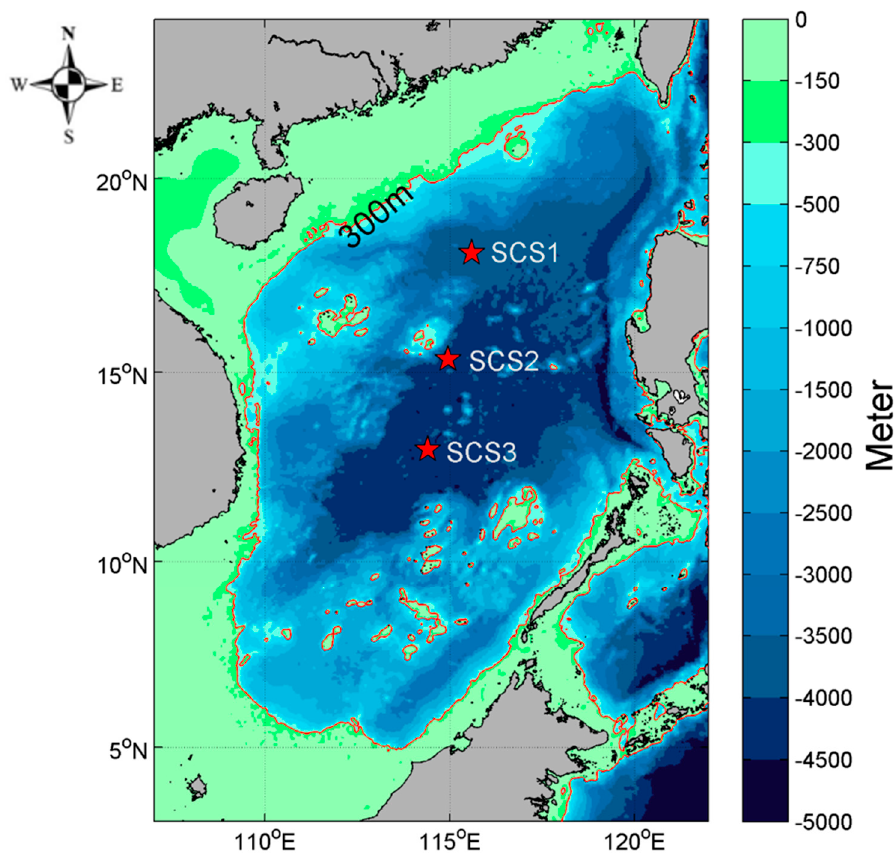
Figure 1. Bottom topography of the South China Sea. The locations of three ATLAS buoys SCS1 (18°5.9 ′ N, 115°35.8 ′ E), SCS2 (15°20.6 ′ N, 114°57.3 ′ E), SCS3 (12°58.5 ′ N, 114°24.5 ′ E) are indicated by red stars.